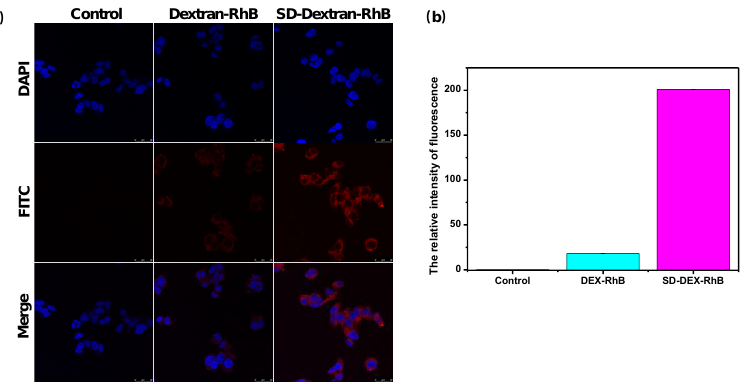
Figure 6. Confocal microscopy images ( a ) and relative intensity of fluorescent intensity ( b ) in HepG2 cells cultured with growth medium, Dextran-RhB, and SD-Dextran-RhB for 2 h.